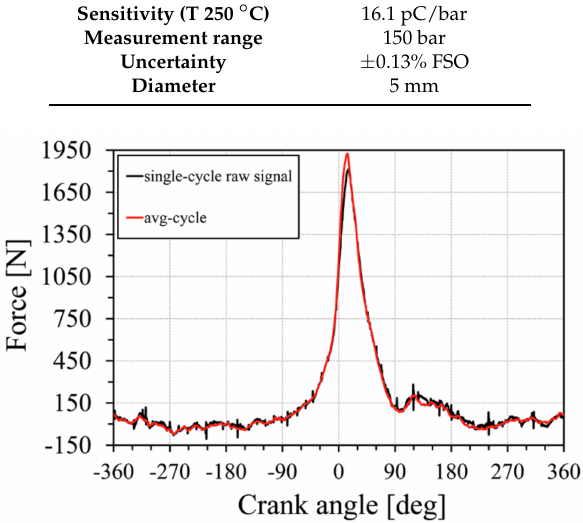
Table 3. Main features of the in-cylinder pressure sensor.